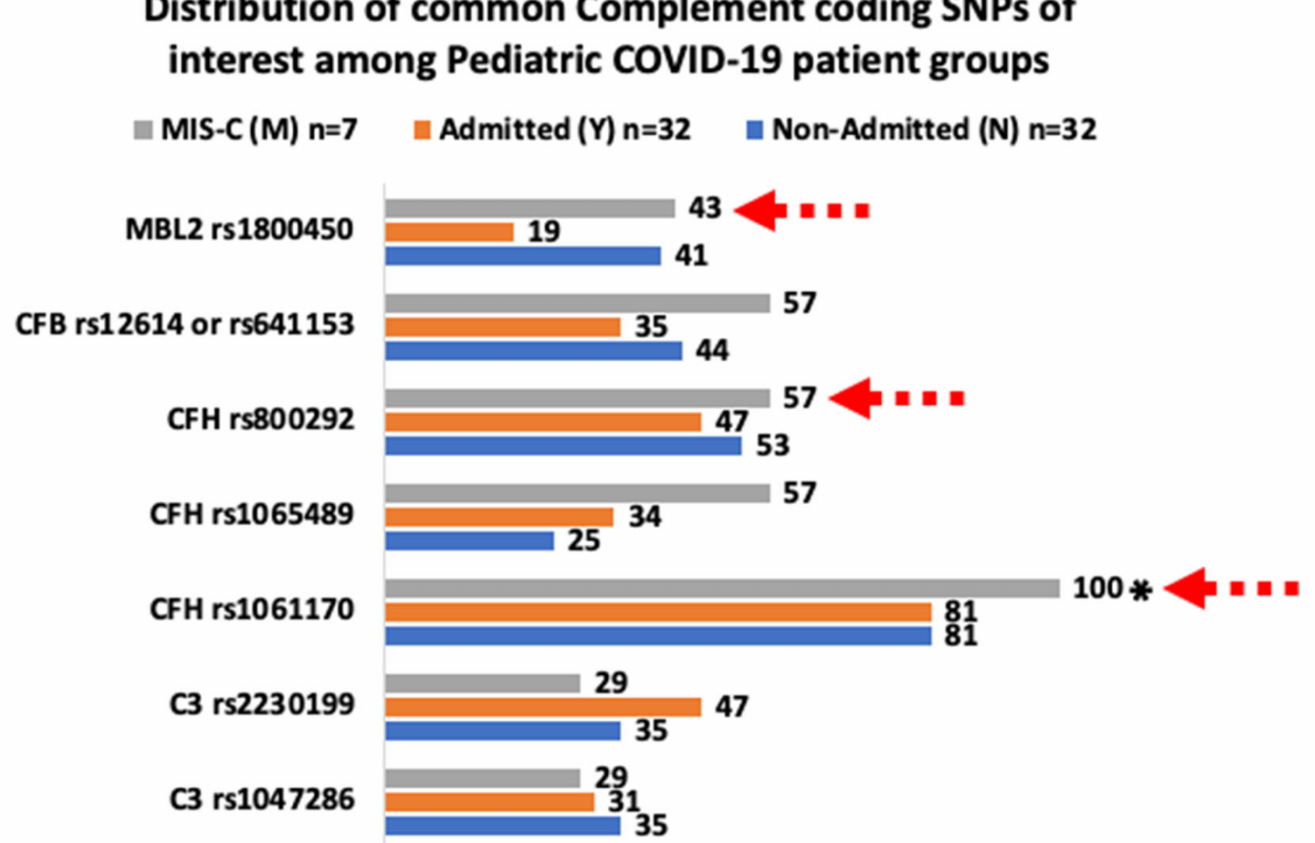
Figure 2. The graph visualizes the data derived from Tables 2 and 3. The red dashed arrows indicate the most striking differences observed for the frequencies of CFB rs12614, rs641153, and CFH rs1061170, rs1065489 among the pediatric COVID-19 patient groups examined. * p = 0.007 for the comparison between the MIS-C and non-MIS-C patients as shown in Table